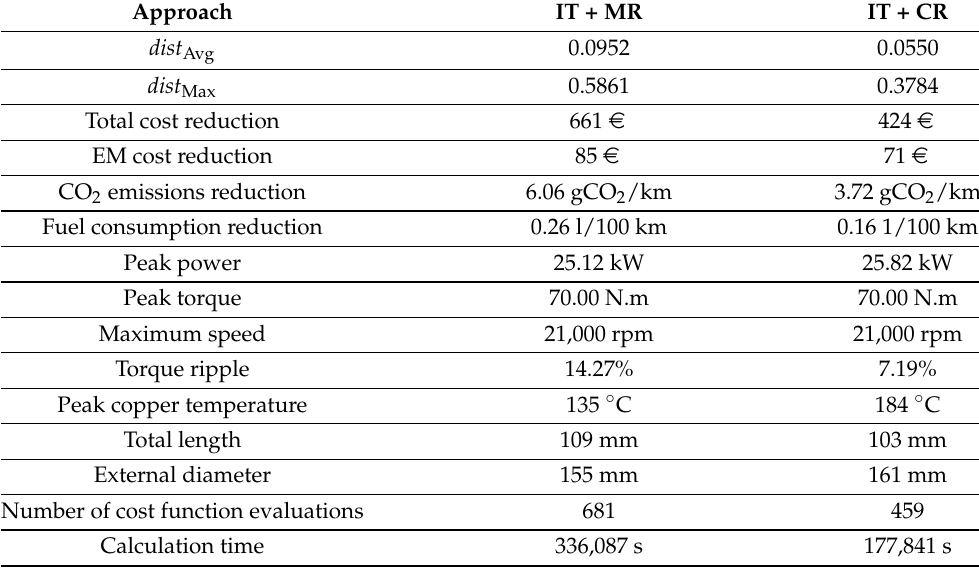
Table 6. Comparison of systemic design approaches based on 10 optimization